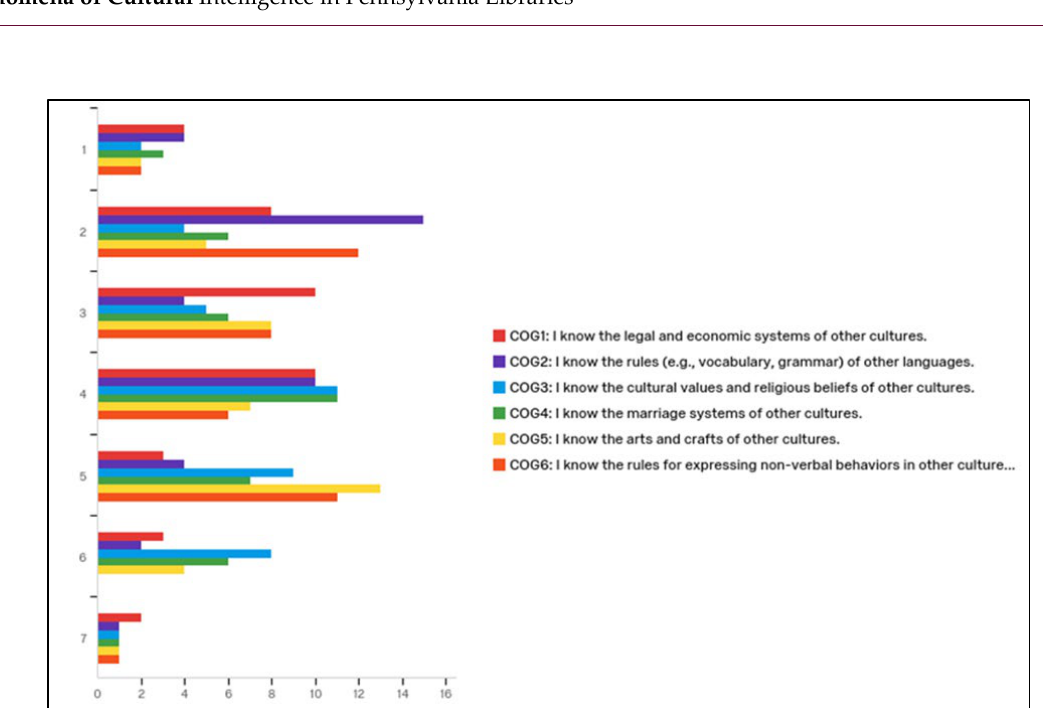
Level of Agreement for CQ Knowledge from CQS